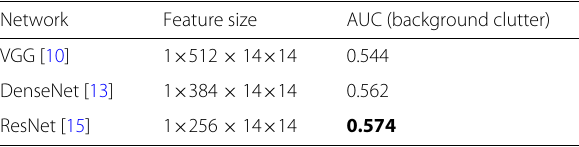
Table 5 Results of different networks